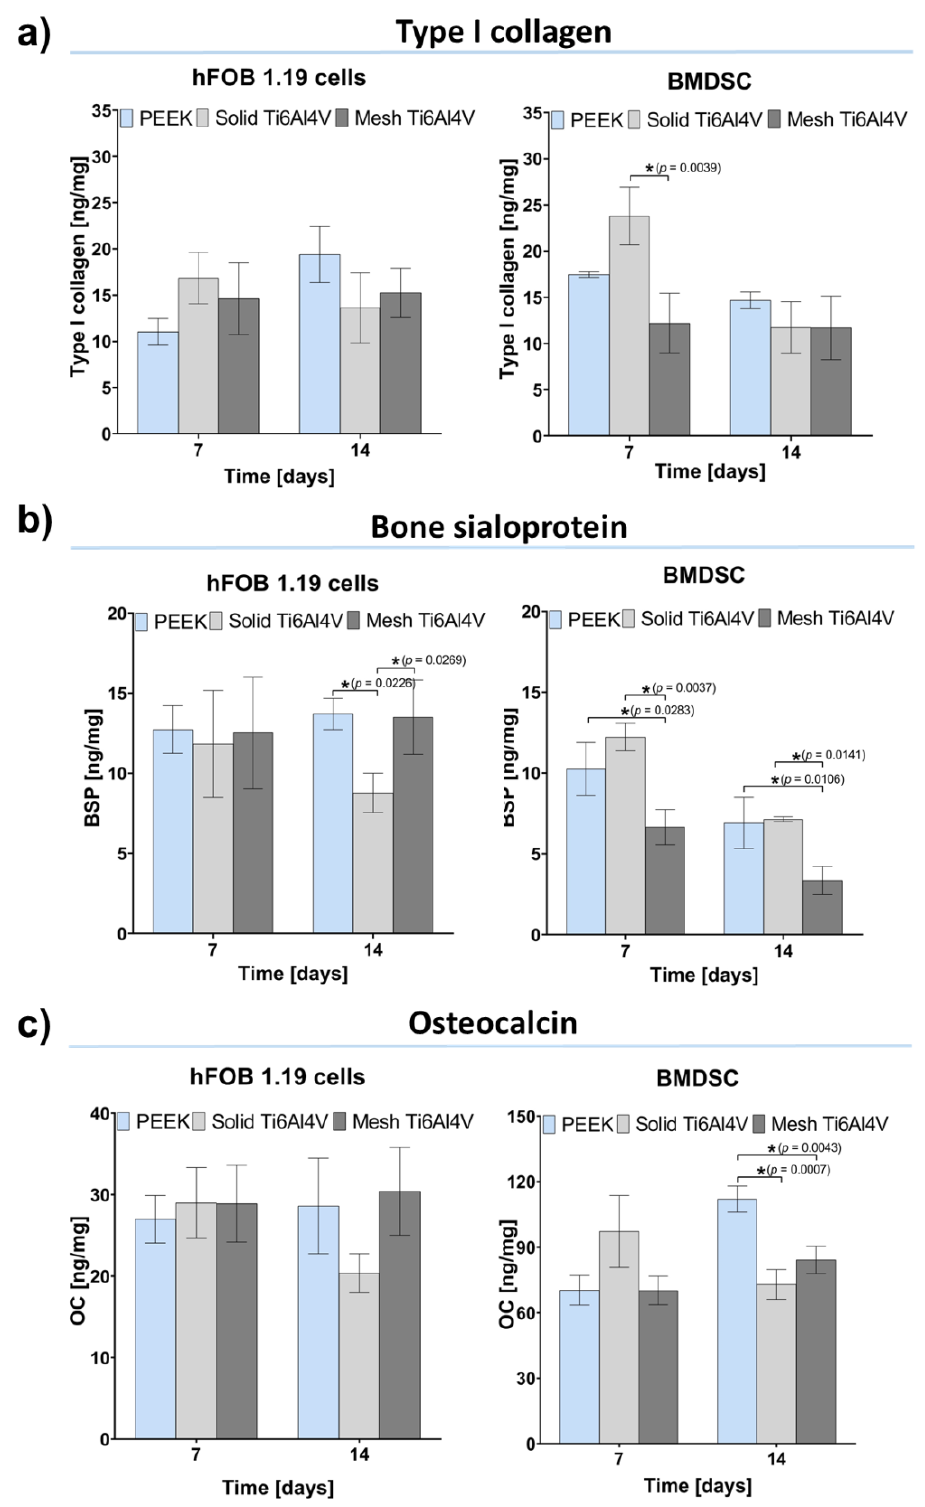
Figure 8. Osteogenic differentiation of the tested materials determined by quantitative evaluation of typical bone formation markers: ( a ) type I collagen (Col I); ( b ) bone sialoprotein (BSP), ( c ) osteocalcin (OC); (* indicates statistically significant results according to One-way ANOVA followed by Tukey’s multiple comparison test).